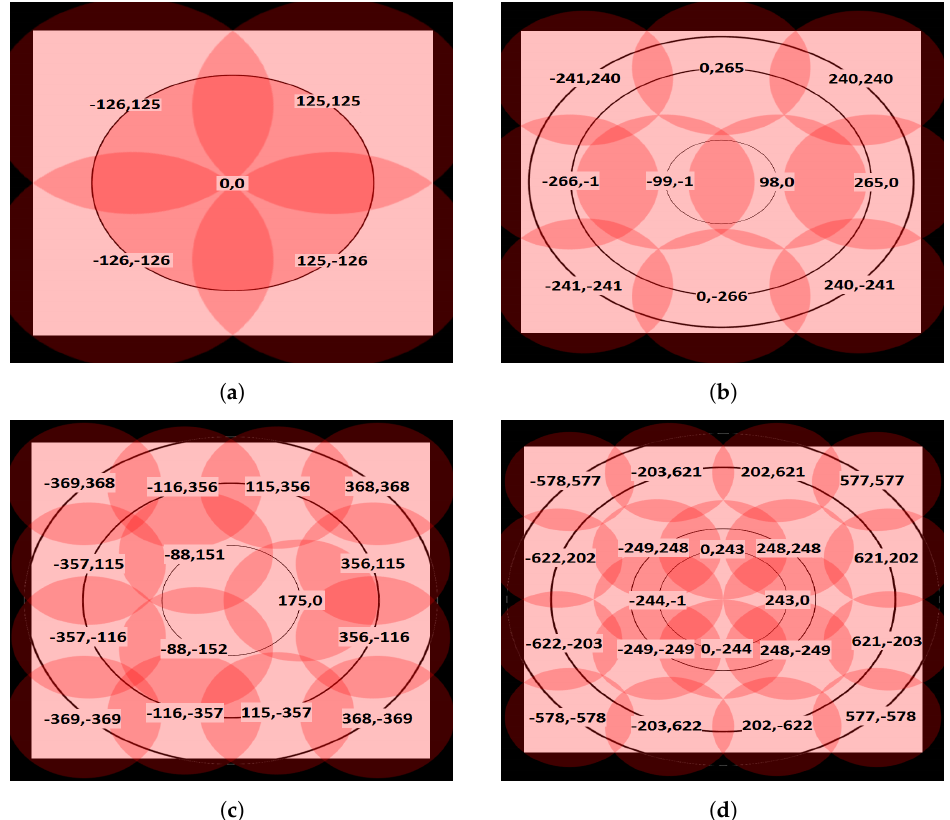
Figure 5. The estimated cluster formatted coverage for the four topology structures using Unity. ( a ) 5 MECs allocation in 500 × 500 m using unity; ( b ) 10 MECs allocation in 700 × 700 m using unity; ( c ) 15 MECs allocation in 1000 × 1000 using unity; ( d ) 20 MECs allocation in 1500 × 1500 using unity. Table 2. System parameters’